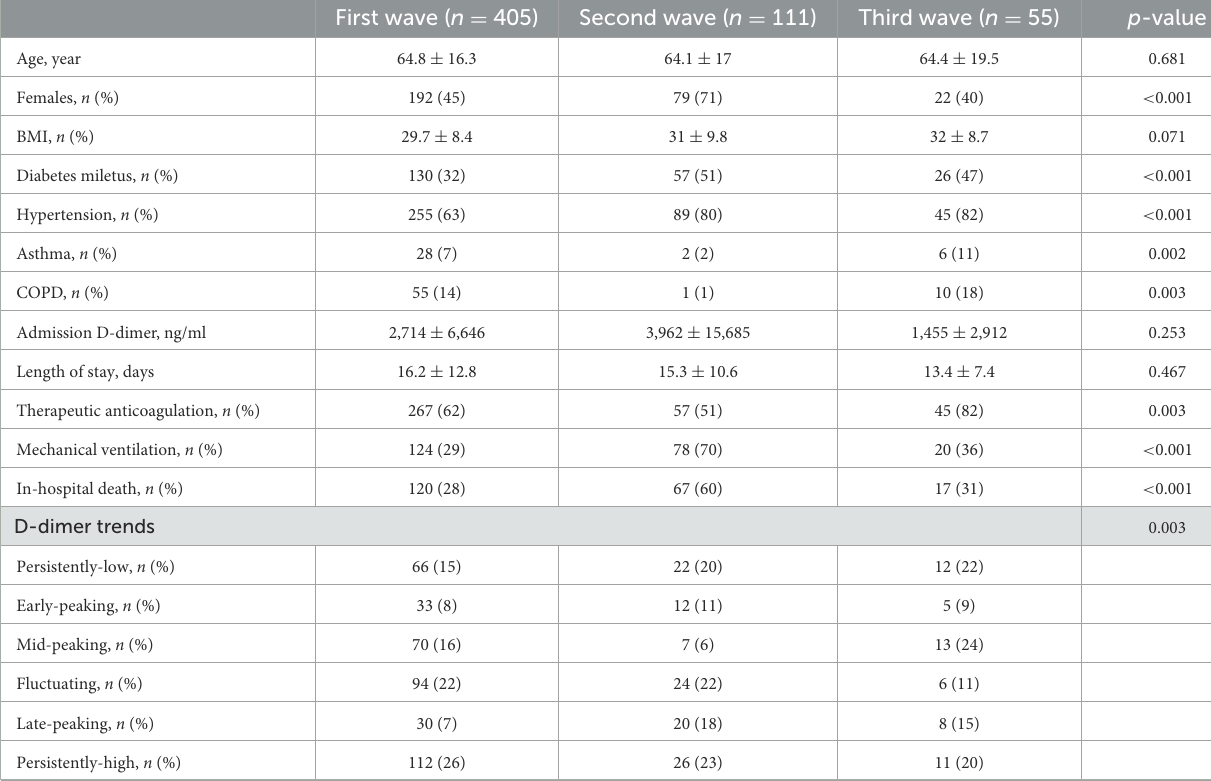
TABLE 1 Comparisons between different